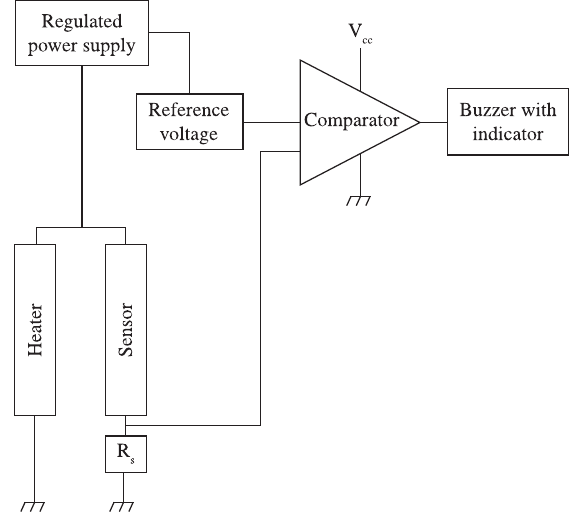
Figure 2. Electronic Circuit of LPG alarm (Schematic arrangement of the alarm circuit used for the Pd-sensitized ZnO sensor).